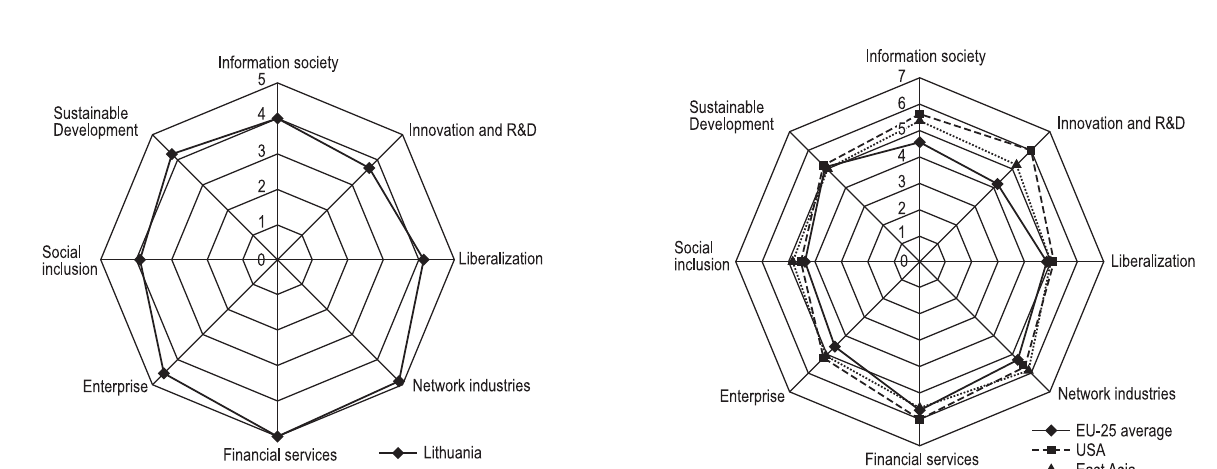
Fig 2. Analysis of progress indexes of Lithuania, EU, USA and Eastern Asian